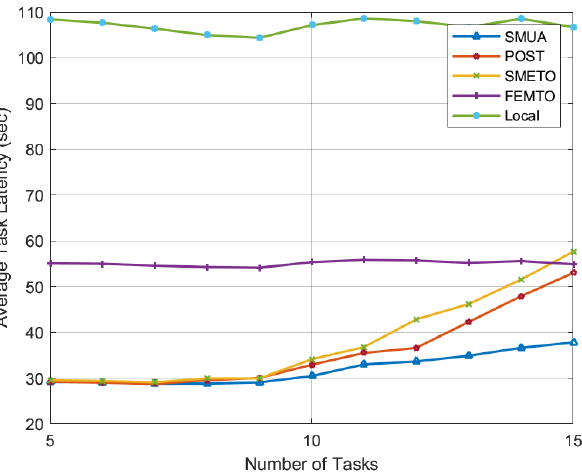
Figure 3. Average task latency with 3 matches permitted for each TN